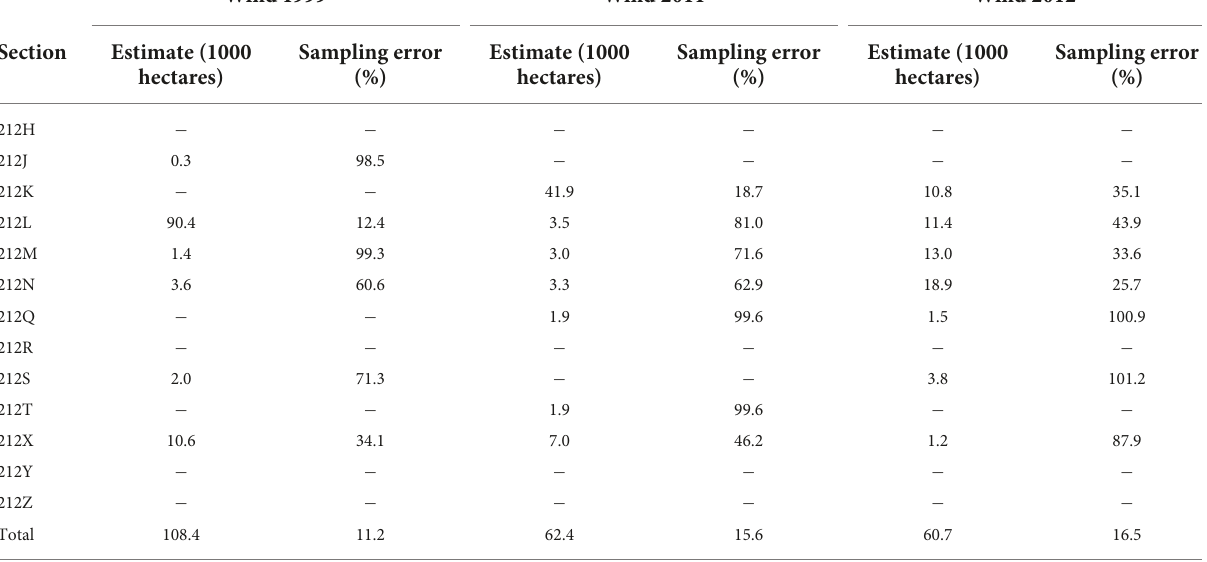
TABLE 8 Annual disturbance estimates for the top three discrete disturbance